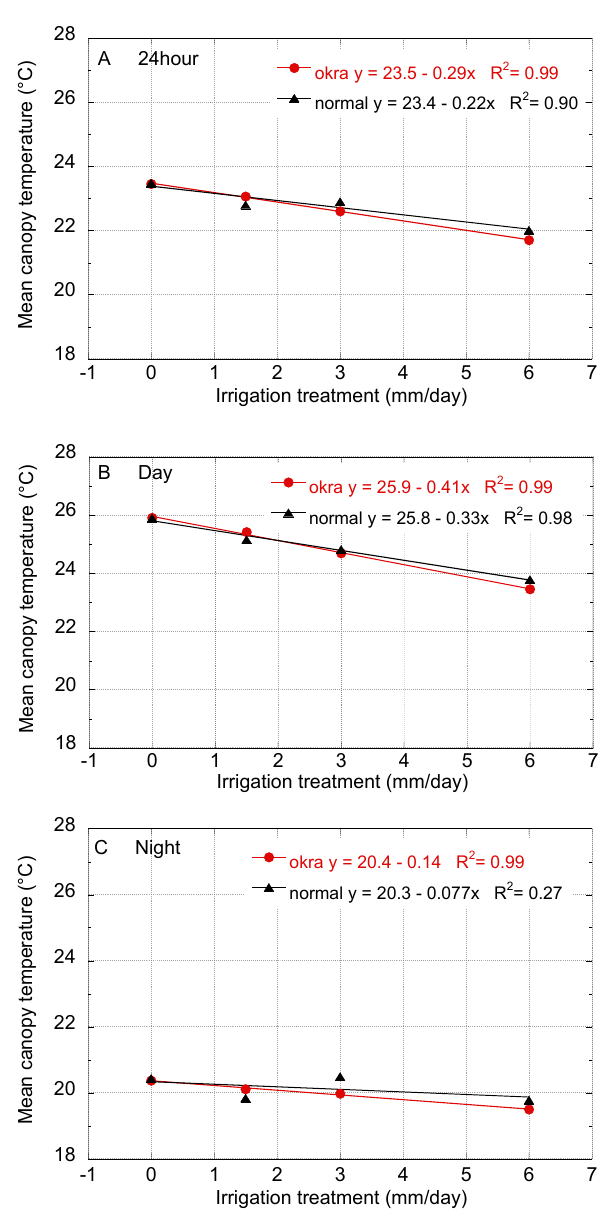
Figure 4. Comparison of mean canopy temperature of the okra and normal leaf varieties over the 120-day study period at four irrigation levels. Three periods of the day are shown; ( A ) 24 h, ( B ) day, and ( C ) night.